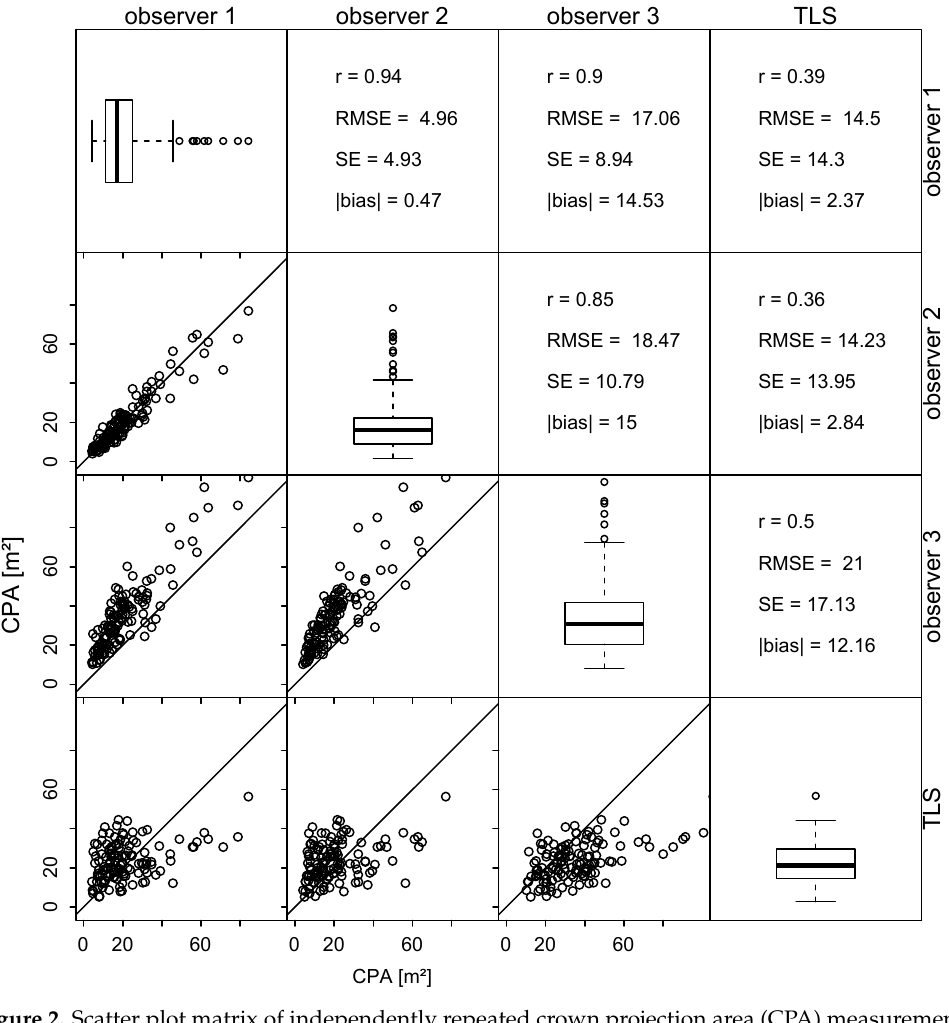
Figure 2. Scatter plot matrix of independently repeated crown projection area (CPA) measurements. Root mean squared error (RMSE), standard error (SE), and absolute bias (|bias|) are estimates given in m 2 . r = Pearson’s correlation coefficient.